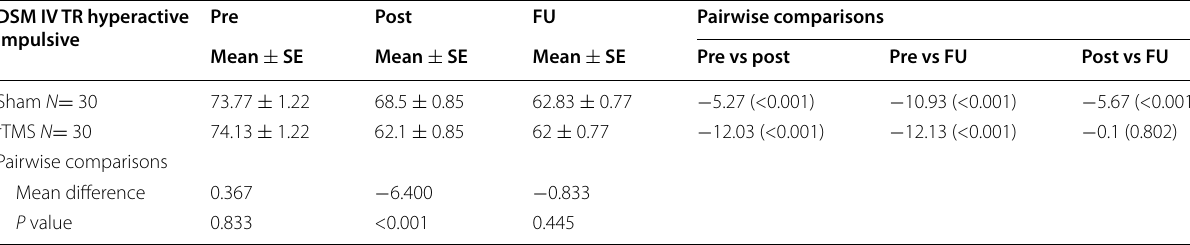
Table 5 Comparing mean DSM IV hyperactive-impulsive T score between the 2 groups at different times DSM IV TR hyperactive